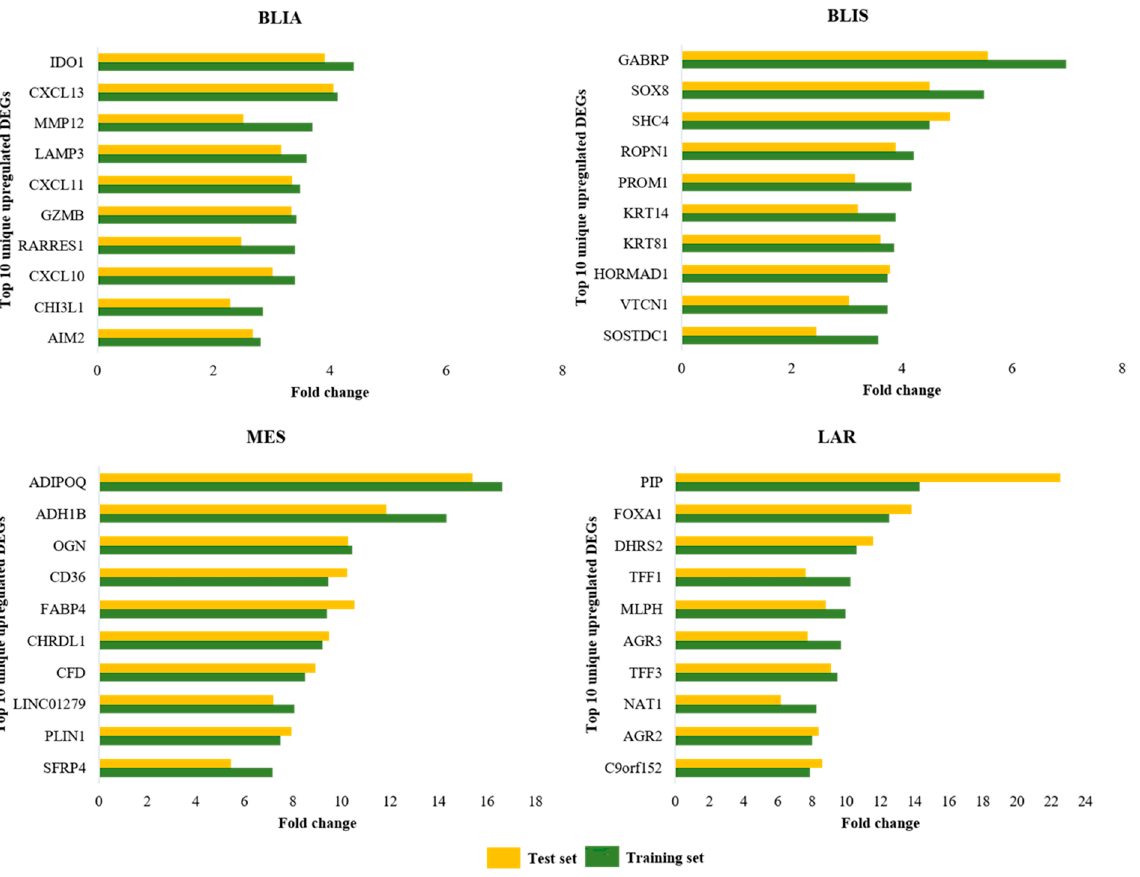
Figure 6. Comparison of fold change of the top 10 upregulated DEGs between the test and training sets of the BLIA, BLIS, MES, and LAR subtypes.